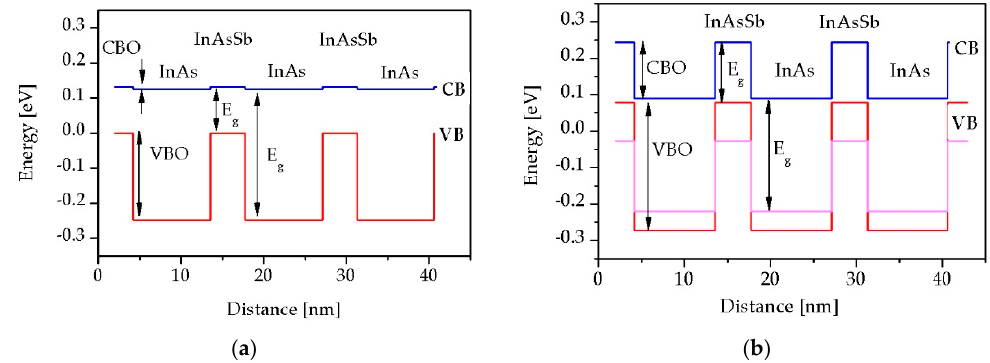
Figure 1. Schematic representation of ( a ) unstrained and ( b ) strained type-II superlattices (T2SLs) InAs/InAs 1 − x Sb x SLs.